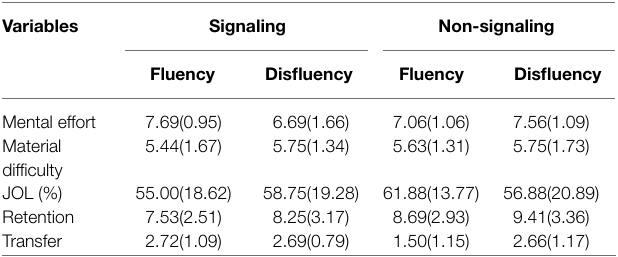
TABLE 1 | Means (and SD/SE) as a function of text disfluency and